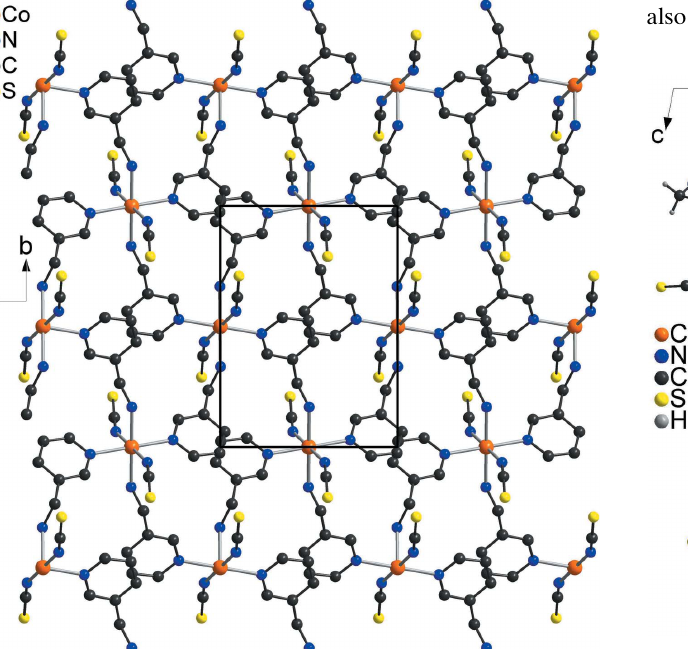
Figure 3 Crystal structure of the title compound viewed along the crystallographic b axis. Intermolecular N—H (cid:2)(cid:2)(cid:2) S hydrogen bonds are shown as dashed lines.